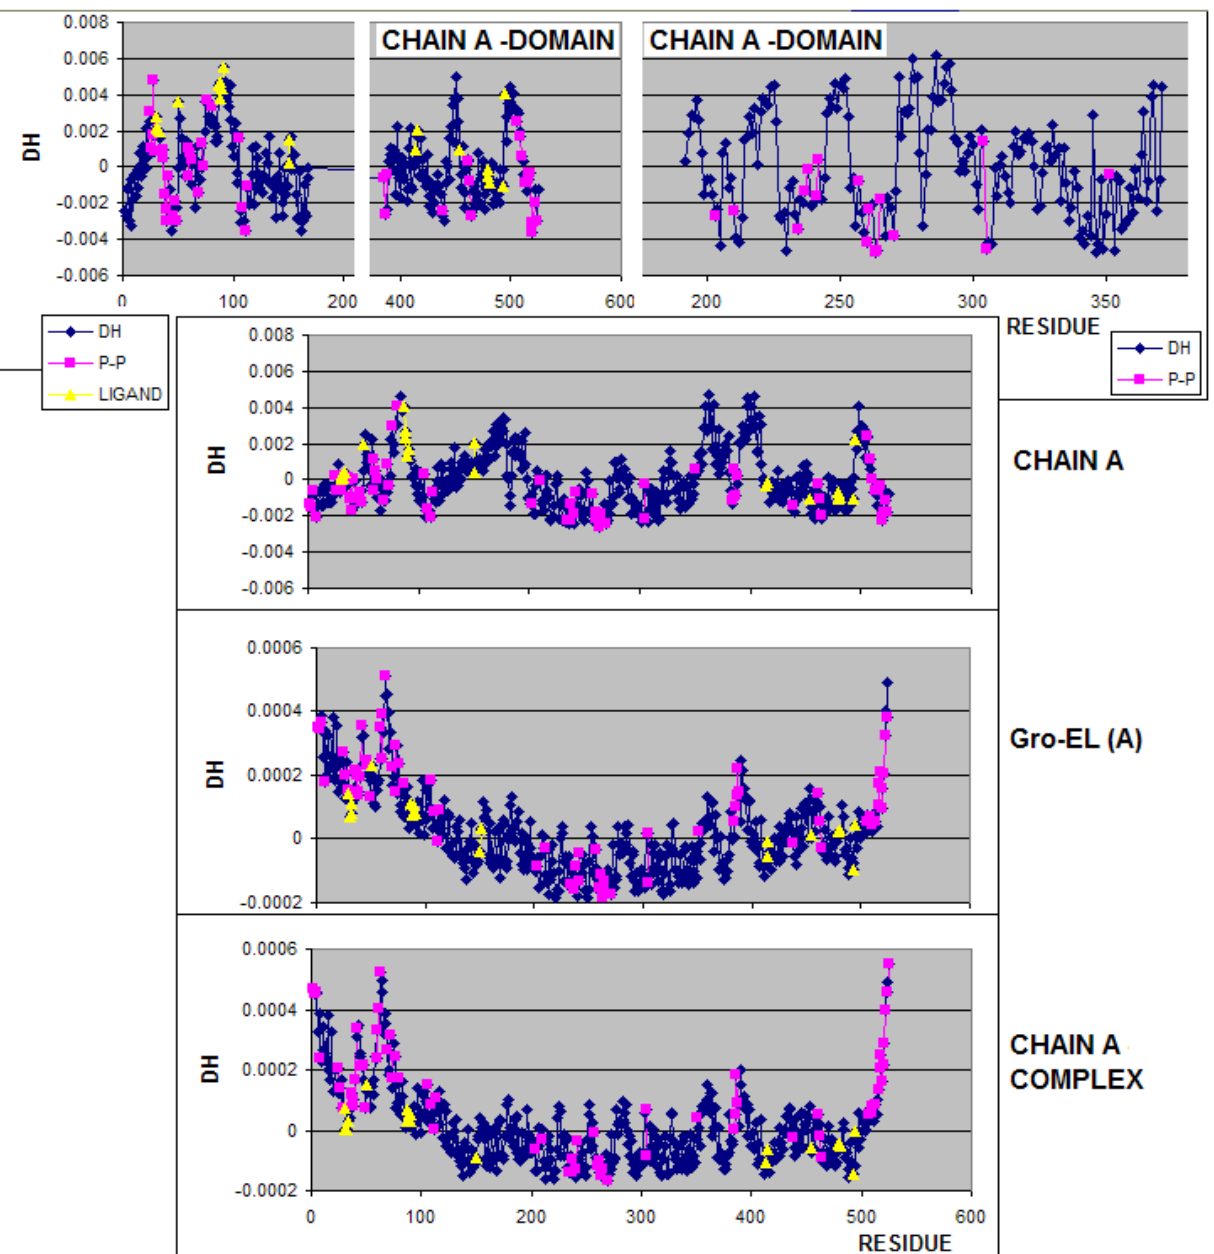
The characteristics of residues engaged in P-P or ligand binding changes due to different relative localization of these residues versus in the “oil drop” construction. ~ Figure 2. The H Δ profiles representing the irregularity of hydrophobicity density distribution in chain A calculated for units defined according to molecule partition: domains, chain, Gro-EL fragment and entire complex GroEL-GroES. The differences are the result of different orientation of chain A versus the oil drop definition. The yellow symbols represent the residues engaged in ligand binding, the pink symbols distinguish the residues engaged in protein-protein (P-P)